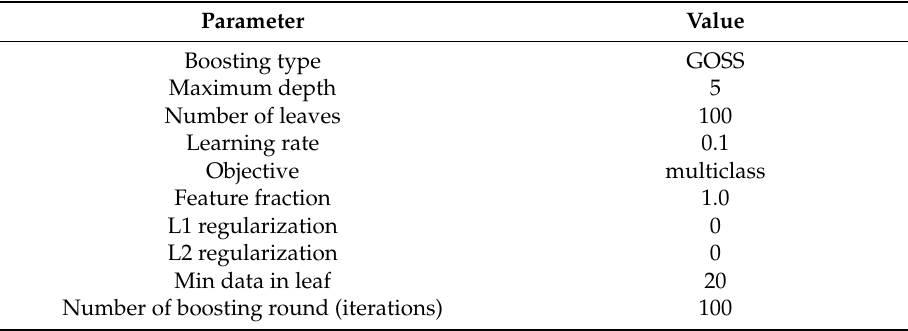
Table 5. Light Gradient Boosting Machine (LightGBM)